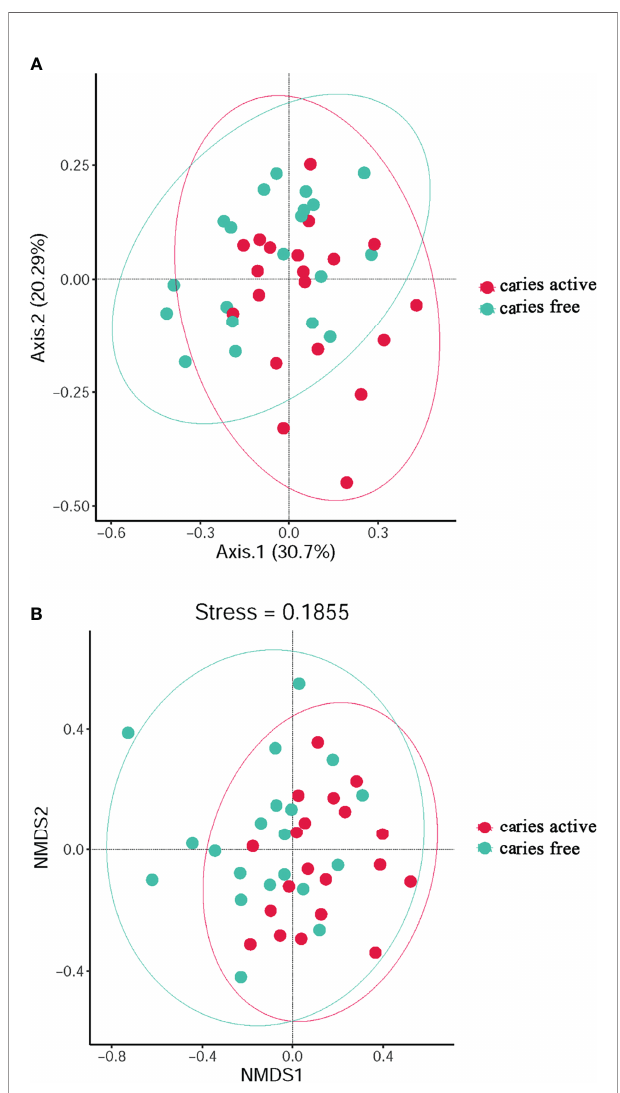
FIGURE 2 | The diversity analysis between groups: PCoA (A) and Non-Metric Multi-Dimensional (B) analysis based on Bray-Curtis distances according to the abundance tables of microbial taxa at the genus level. Circles in different colors represent different